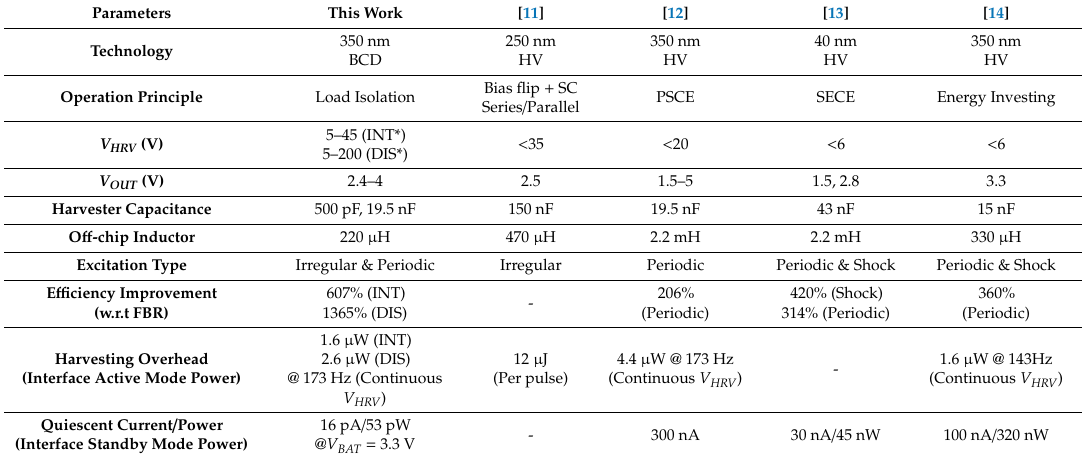
Table 1. Performance comparison with prior harvesting